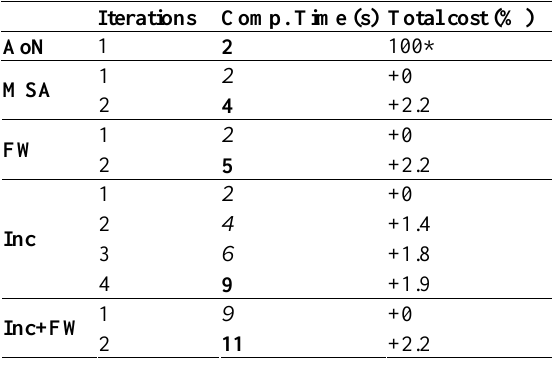
Table 6. Results on non-congested sample network